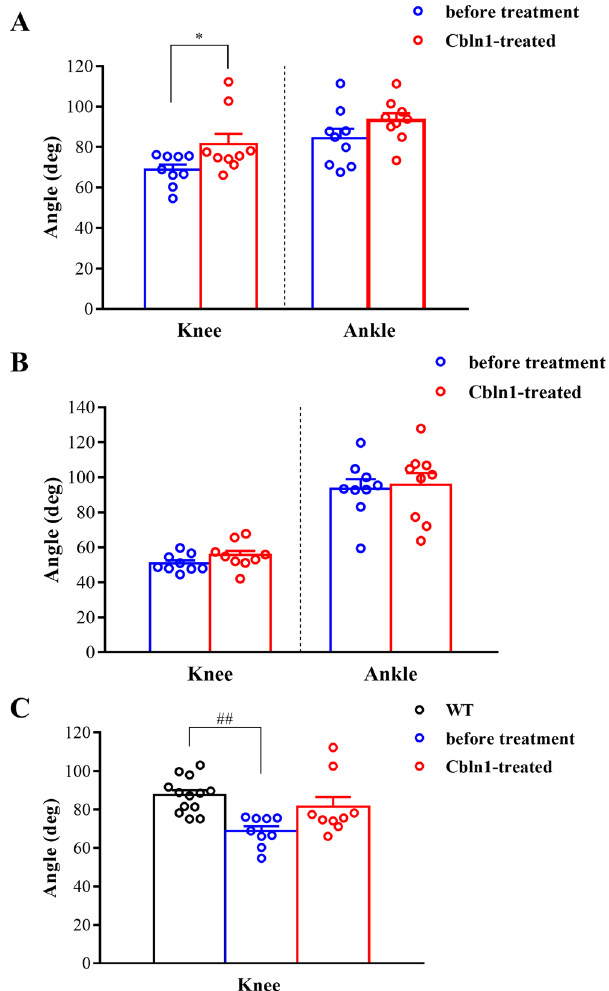
Figure 7. Angle at foot contact and foot lift after injection of Cbln1. Average knee and ankle angles at foot contact ( A ) and foot lift ( B ) in cbln1 -null mice before (blue) and after (red) injection of Cbln1. ( C ) Knee angles of cbln1 - null mice and wild-type mice after Cbln1 treatment. * p < 0.05 (paired- t test), ## p < 0.01 (one-way ANOVA, Tukey post-hoc